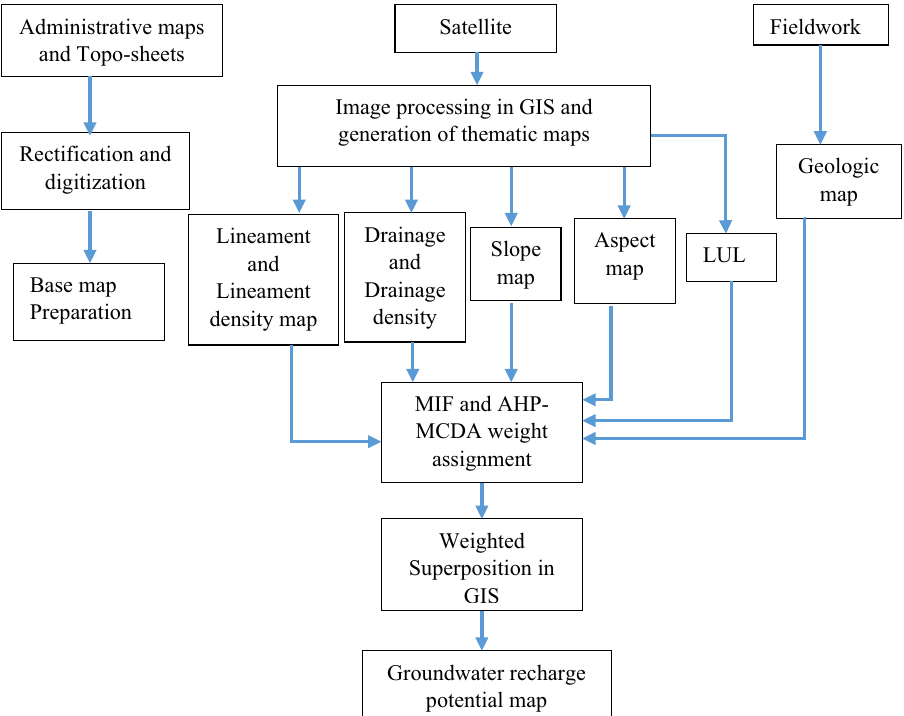
Fig. 2 Materials and methods used to delineate groundwater recharge potential